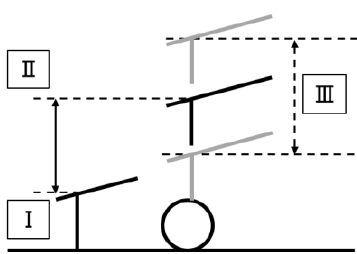
Figure 1. Difference in the initial position between the normal atomic force microscopy (AFM) contact mode operation (I) and force – distance curve mapping (II). The range marked as III shows the amplitude of the moving tip.